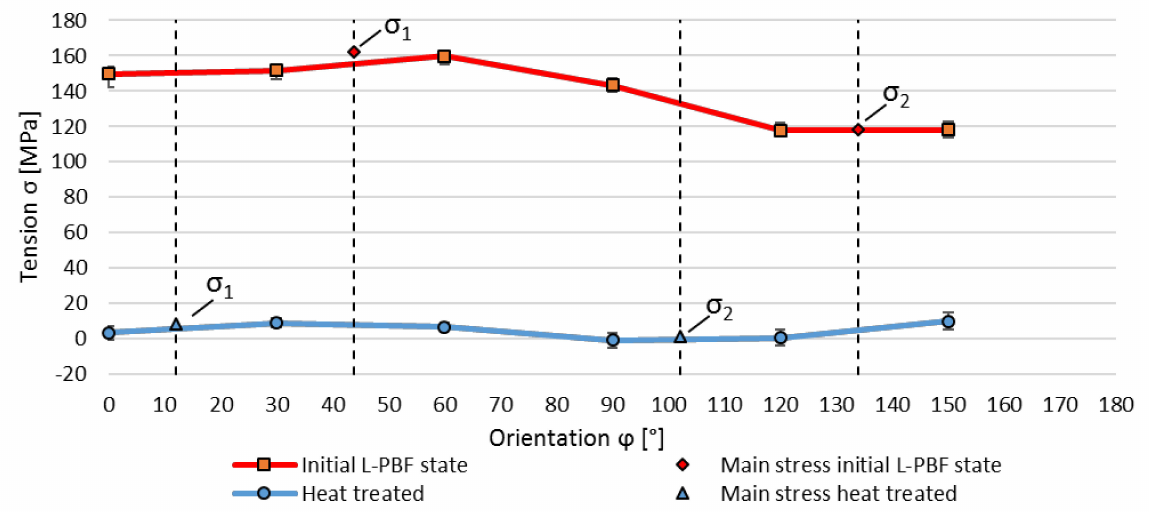
Figure 16. Residual tensile stress depending on the orientation ϕ , and principal stresses at the initial L-PBF state and heat-treated state, measured by